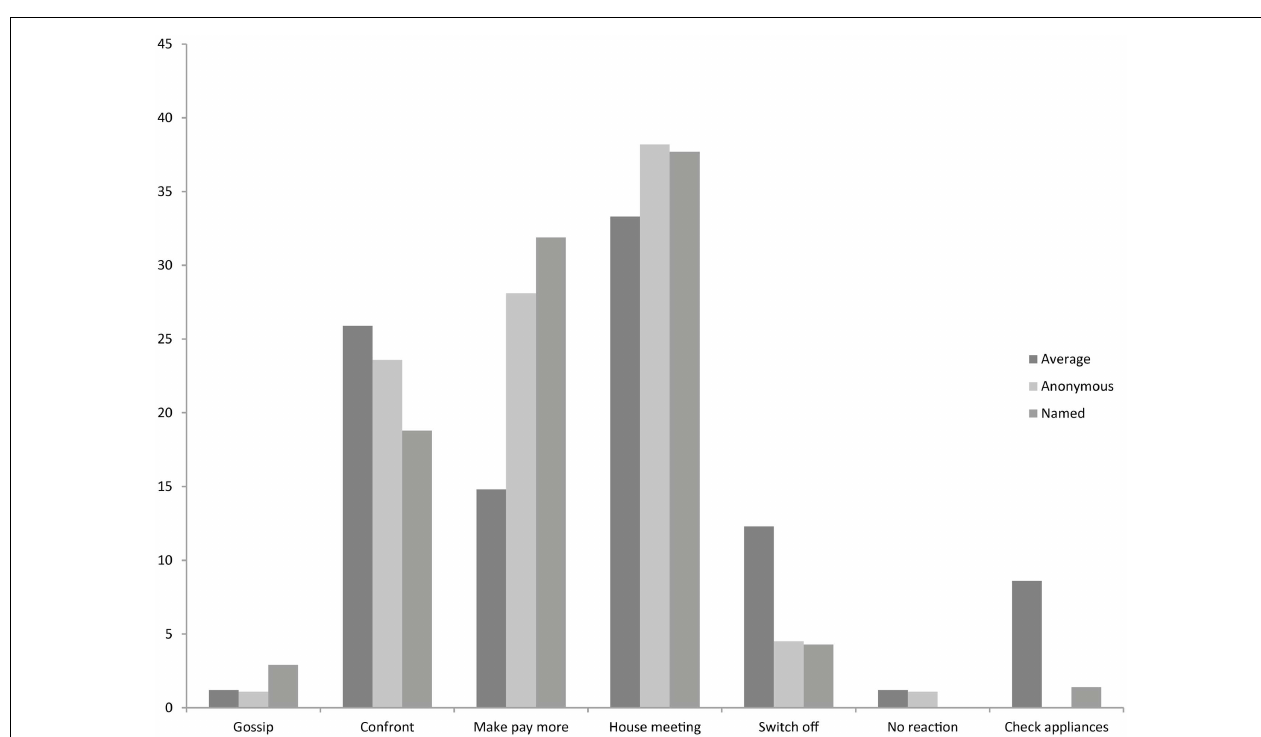
FIGURE 4 | Percentage of preference for each reaction to free-riding as a function of type of display (the reactions that are not displayed were never chosen by participants)